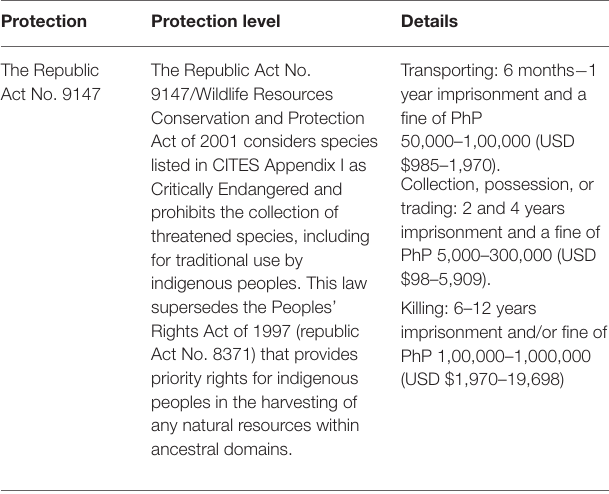
TABLE 1 | National regulations in the Philippines relating to the transport, collection or killing of Critically Endangered